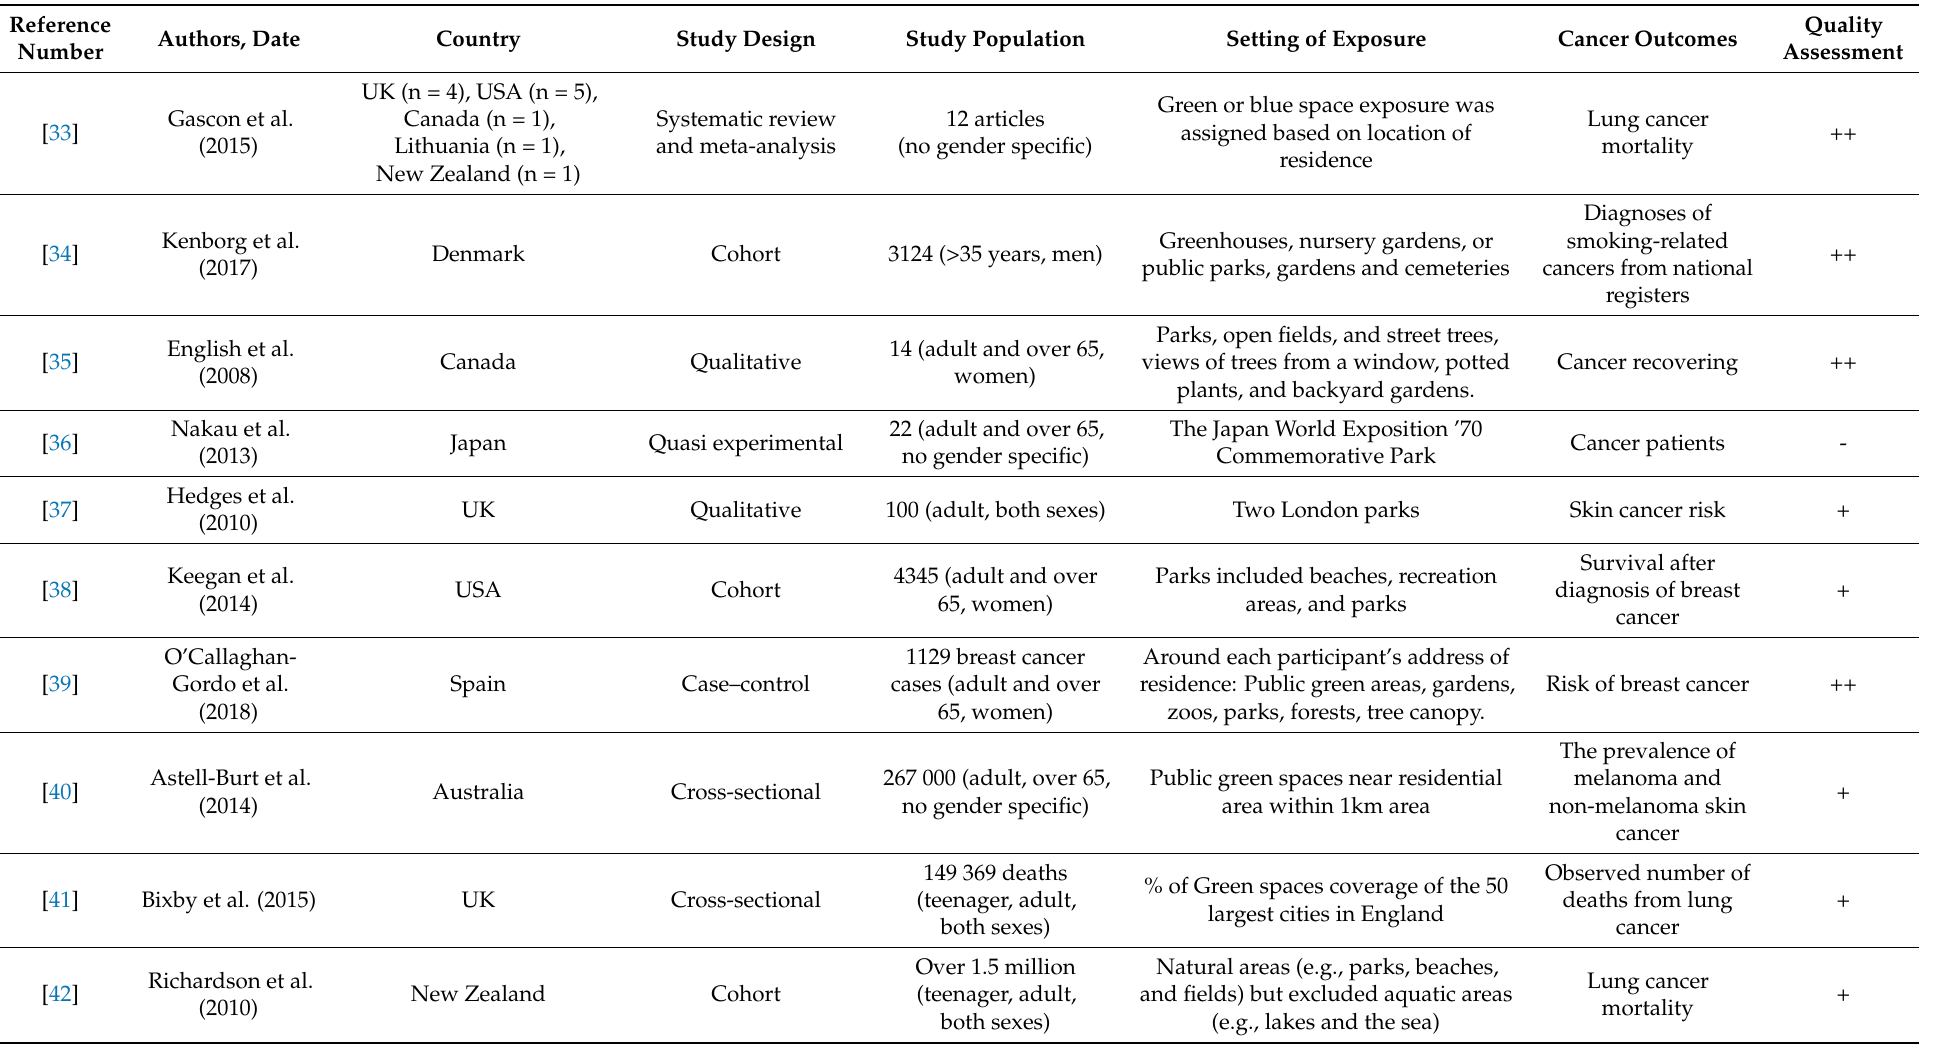
Table 1. General characteristics of the included studies ( n =